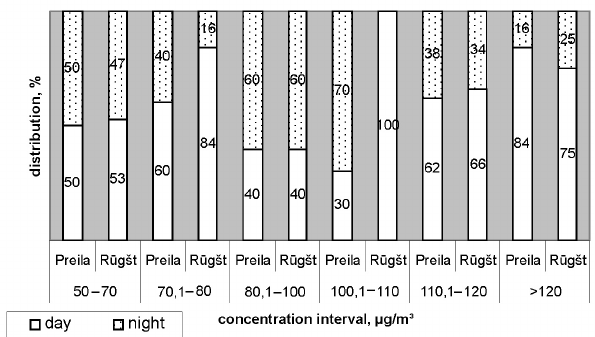
Fig 2. Distribution of cases with warm front at different ozone concentration intervals in Preila and R ū gštelišk ė s during day and night hours